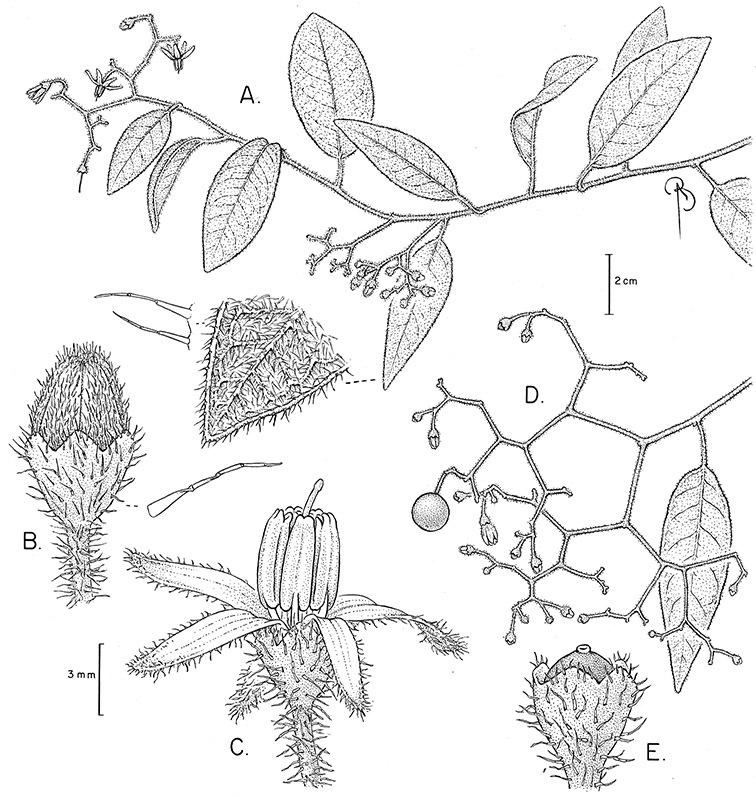
Solanum aspersum S. Knapp. (A–C drawn from MacDougal et al. 4251
D–E from Zak 1857A). Originally published in Knapp (2010). Illustration by Bobbi Angell.